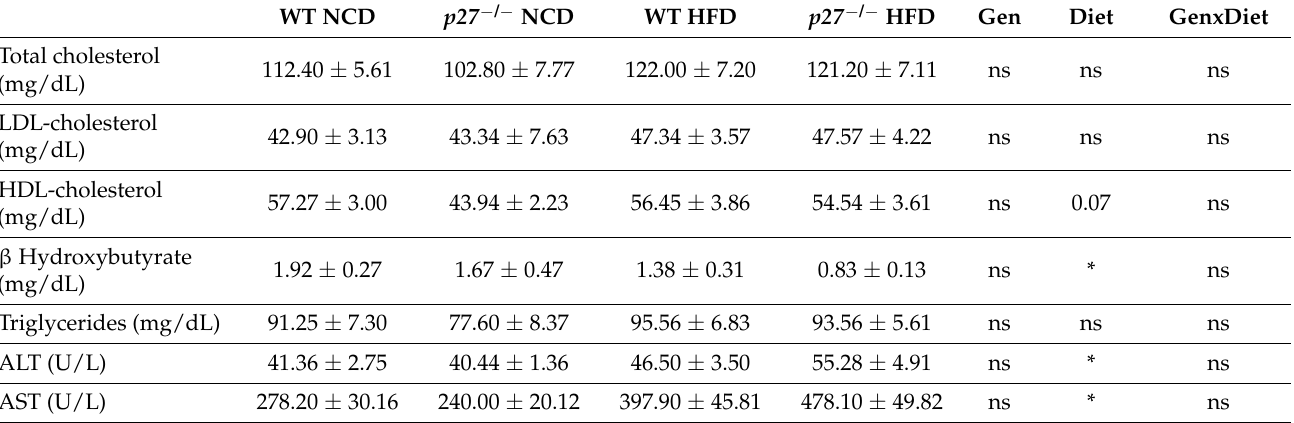
Table 1. Serum biochemical parameters in WT and p27 − / − mice fed with NCD or HFD for 10